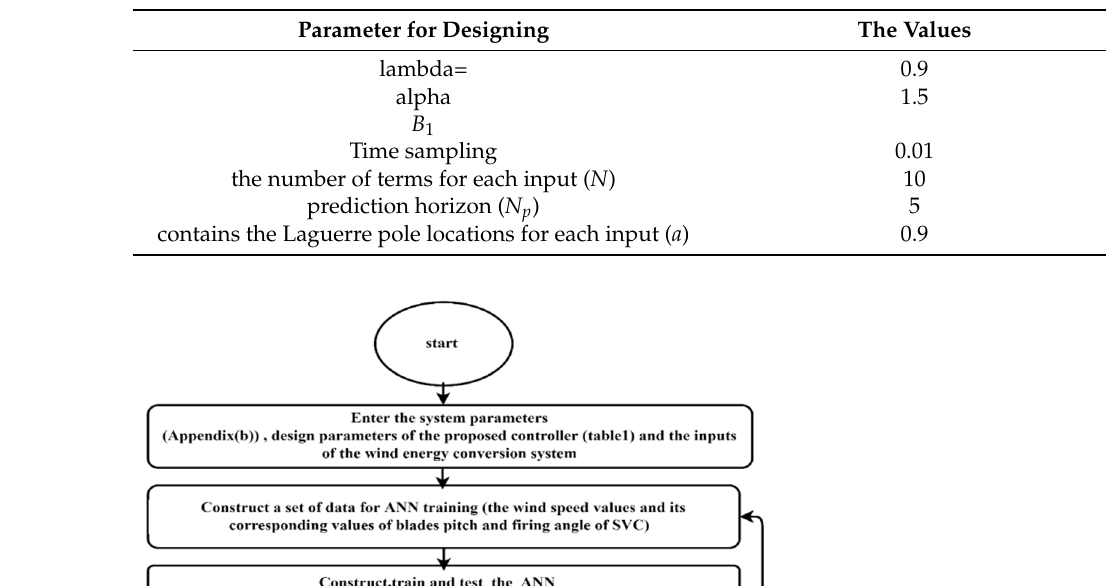
Table 1. Shows the initial values for designing the of the neuro-predictive controller.